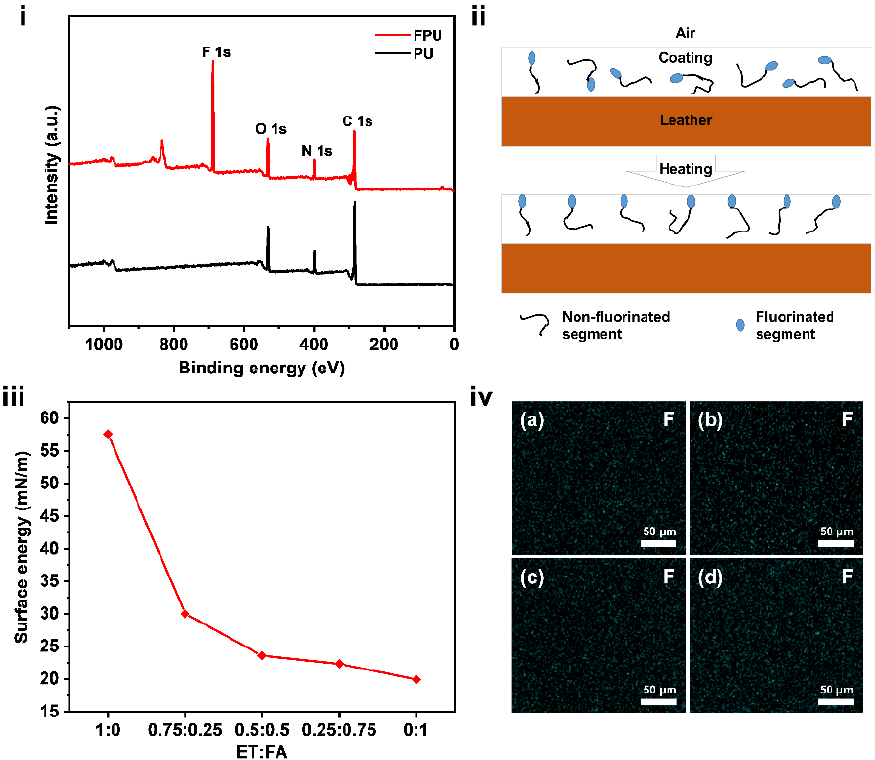
Figure 2. ( i ) XPS spectra of surface survey of pure PU (ET:FA = 1:0) coating and FPU coating (ET:FA = 0.5:0.5); ( ii ) Schematic representation of surface enrichment of fluorinated segments on the coating during the drying and curing process; ( iii ) Surface energy of the coatings against molar feed proportions of ET:FA; ( iv ) Fluorine atom (F) EDS mappings of the FPU coatings at different molar feed proportions of ET:FA. ( a ) 0.75:0.25, ( b ) 0.5:0.5, ( c ) 0.25:0.75, ( d ) 0:1.